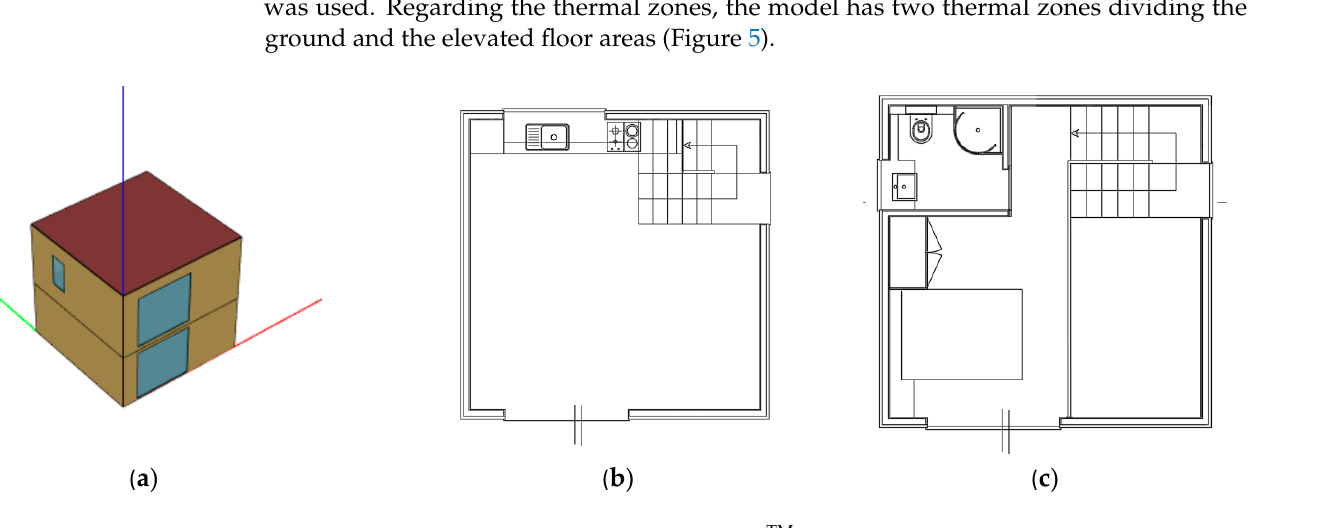
Figure 5. Numerical model design in EnergyPlus TM : ( a ) 3D model; ( b ) and ( c ) tiny house architectural blueprints (no scale).